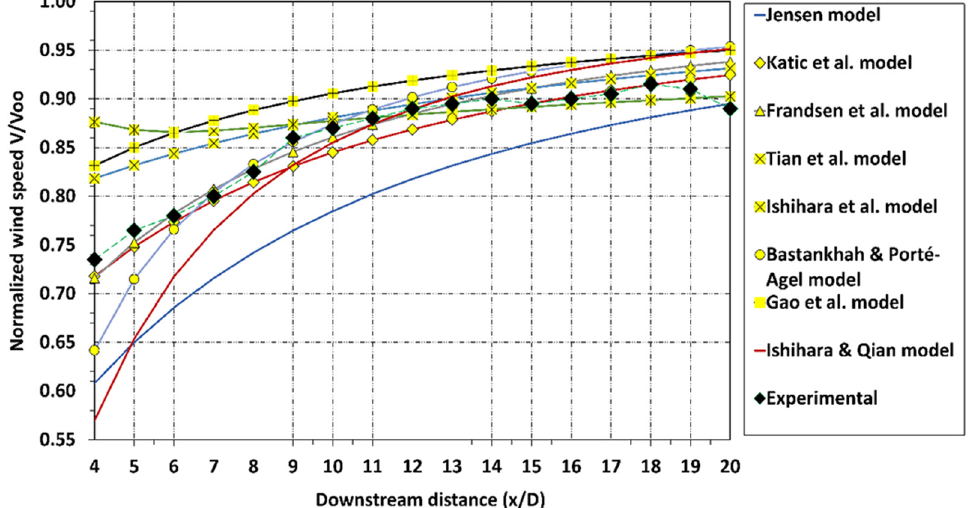
Fig. 10. Experimental and calculated wake development for upstream wind speed value equal to 17m/s.